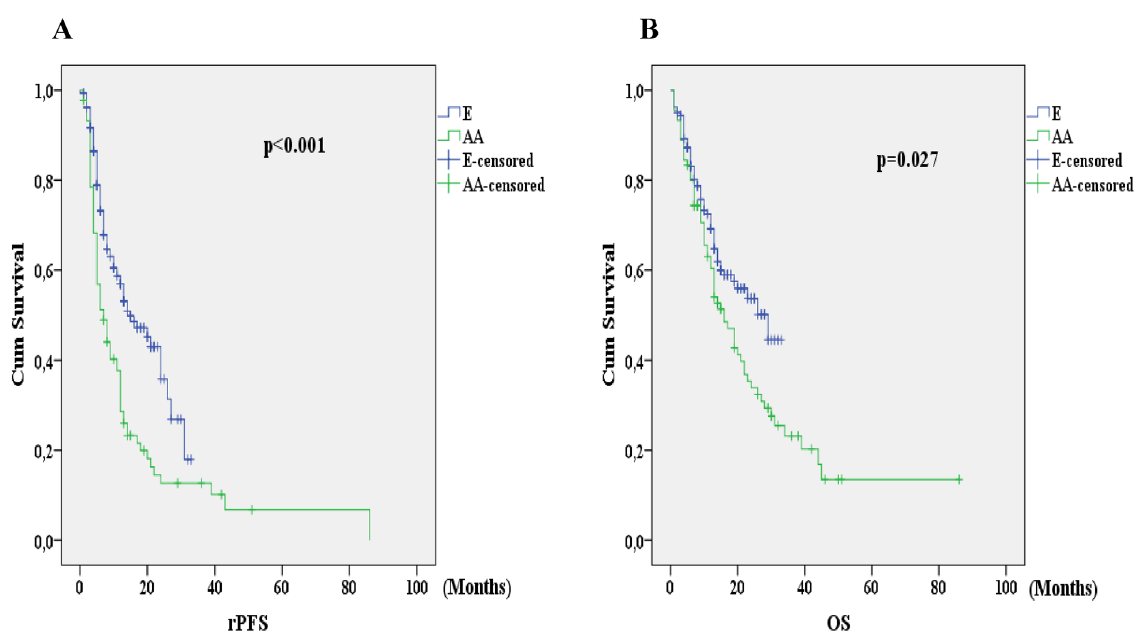
Figure 2. ( A ) Radiological progression free survival in all patients. ( B ) Overall survival in all patients depending on two drugs. E enzalutamide, AA abiraterone acetate, rPFS radiological progression free survival, OS overall